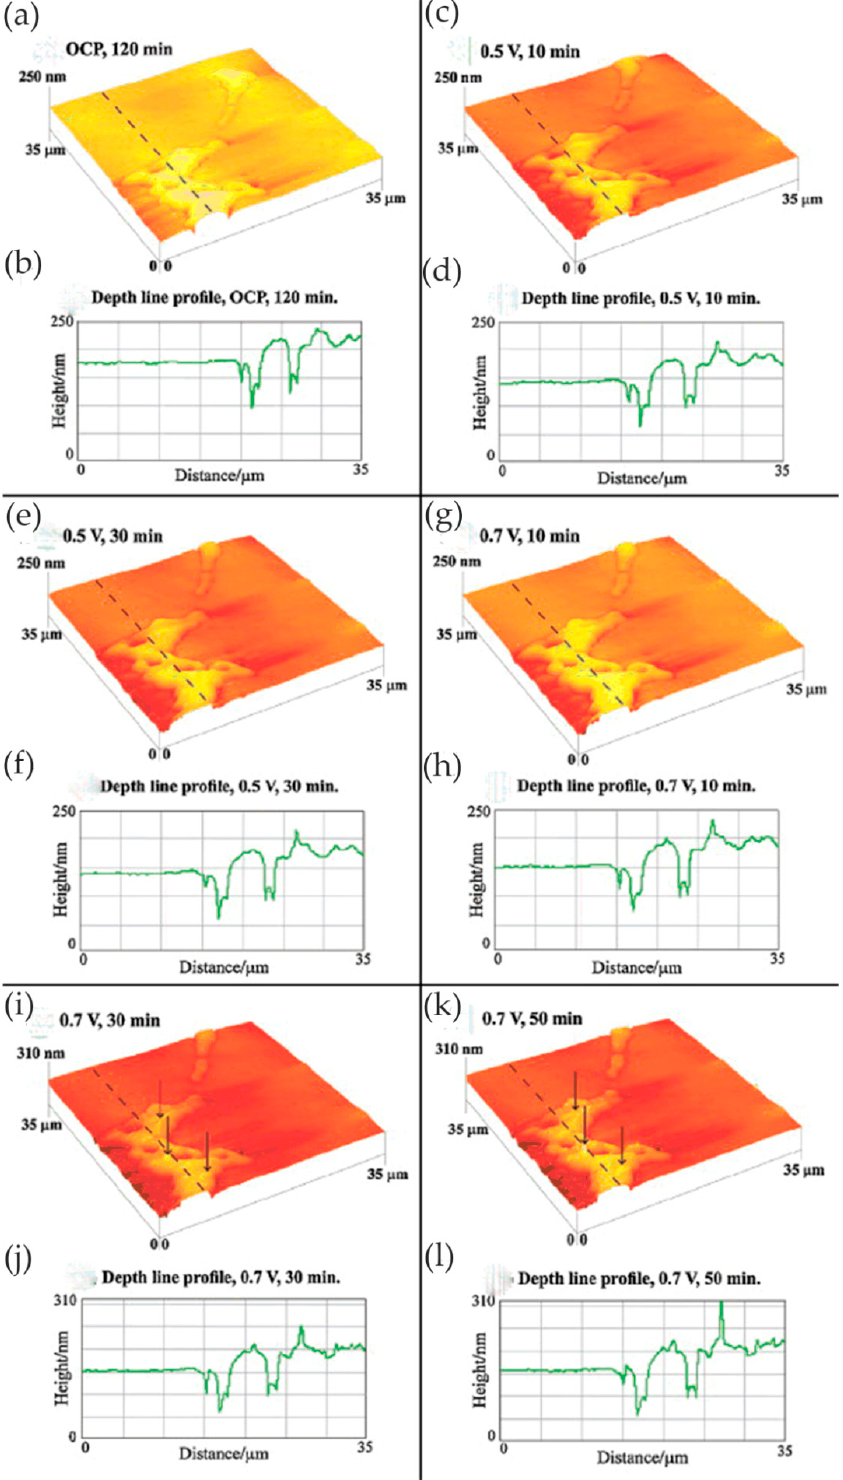
Figure 28. In situ AFM images of the same area of CoCrMo alloy under electrochemical control in PBS solution with pH 7.4, ( a ) after 120 min at OCP, ( c , e ) after 10 and 30 min at 0.5 Vsat Ag/AgCl, and ( g , i , k ) after 10, 30, and 50 min at 0.7 Vsat Ag/AgCl, with marked etching-like dissolution sites on the carbide (where visible). ( b , d , f , h , j , l ) Depth line profiles at the applied potential and time. Adapted with permission from Reference [64]; copyright 2011 Elsevier Ltd.